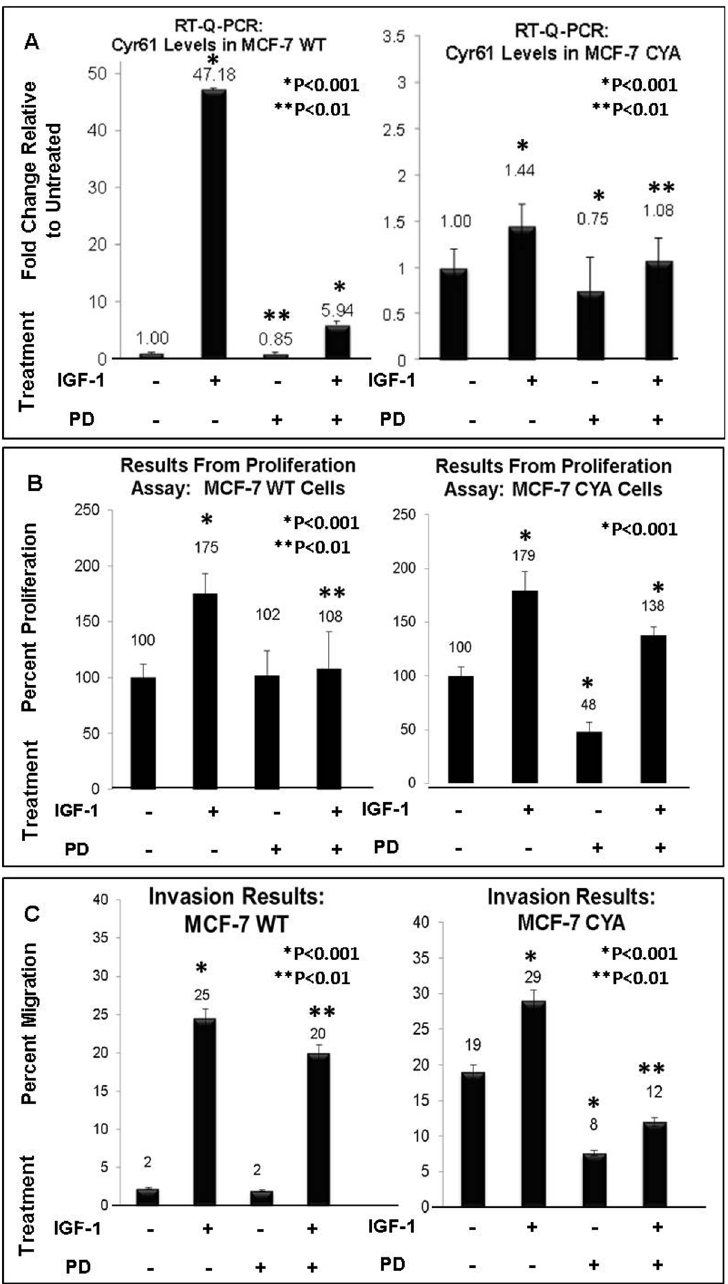
Figure 4. Effects of IGF-1 and PD98059 Induction on Proliferation, Invasion, and Cyr61 Expression in MCF-7 WT and MCF-7 CYA. ( A ) The mRNA expression of Cyr61 was assessed by RT-Q-PCR. All mRNA levels were adjusted for the housekeeping gene, 18S. ( B ) Proliferation assay summary data after 48 hour IGF-1 (100 ng/mL) and PD98059 (30 m M) treatment in MCF-7 WT and MCF-7 CYA. Each condition was plated into 6 identical wells in a 96 well plate. All treatments were standardized relative to the untreated condition for each cell line. ( C ) Results from Invasion assay after 40 hour IGF-1 (100 ng/mL) and PD98059 (30 m M) treatment in MCF-7 WT and MCF-7 CYA. P-values were assessed relative to the untreated condition in each assay, with P , 0.05 considered statistically significant.